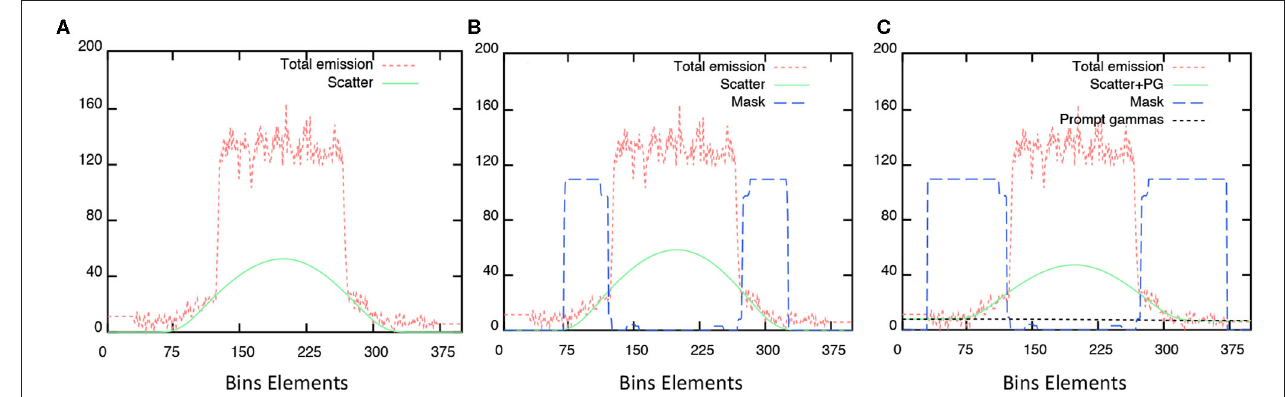
FIGURE 2 | Profiles obtained from measured sinograms superimposed with the estimated scatter corrections applied: (A) absolute scatter correction; (B) relative scatter correction, and; (C) with PGC.